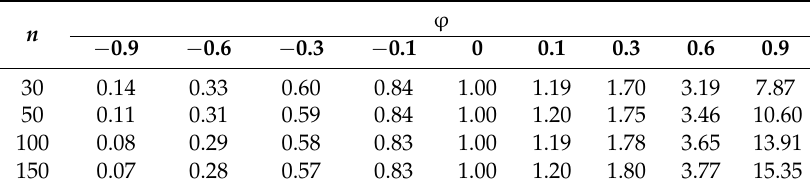
Table 1. Variance inflation factor V ( ρ )/ var ( ρ ) for AR(1) model.